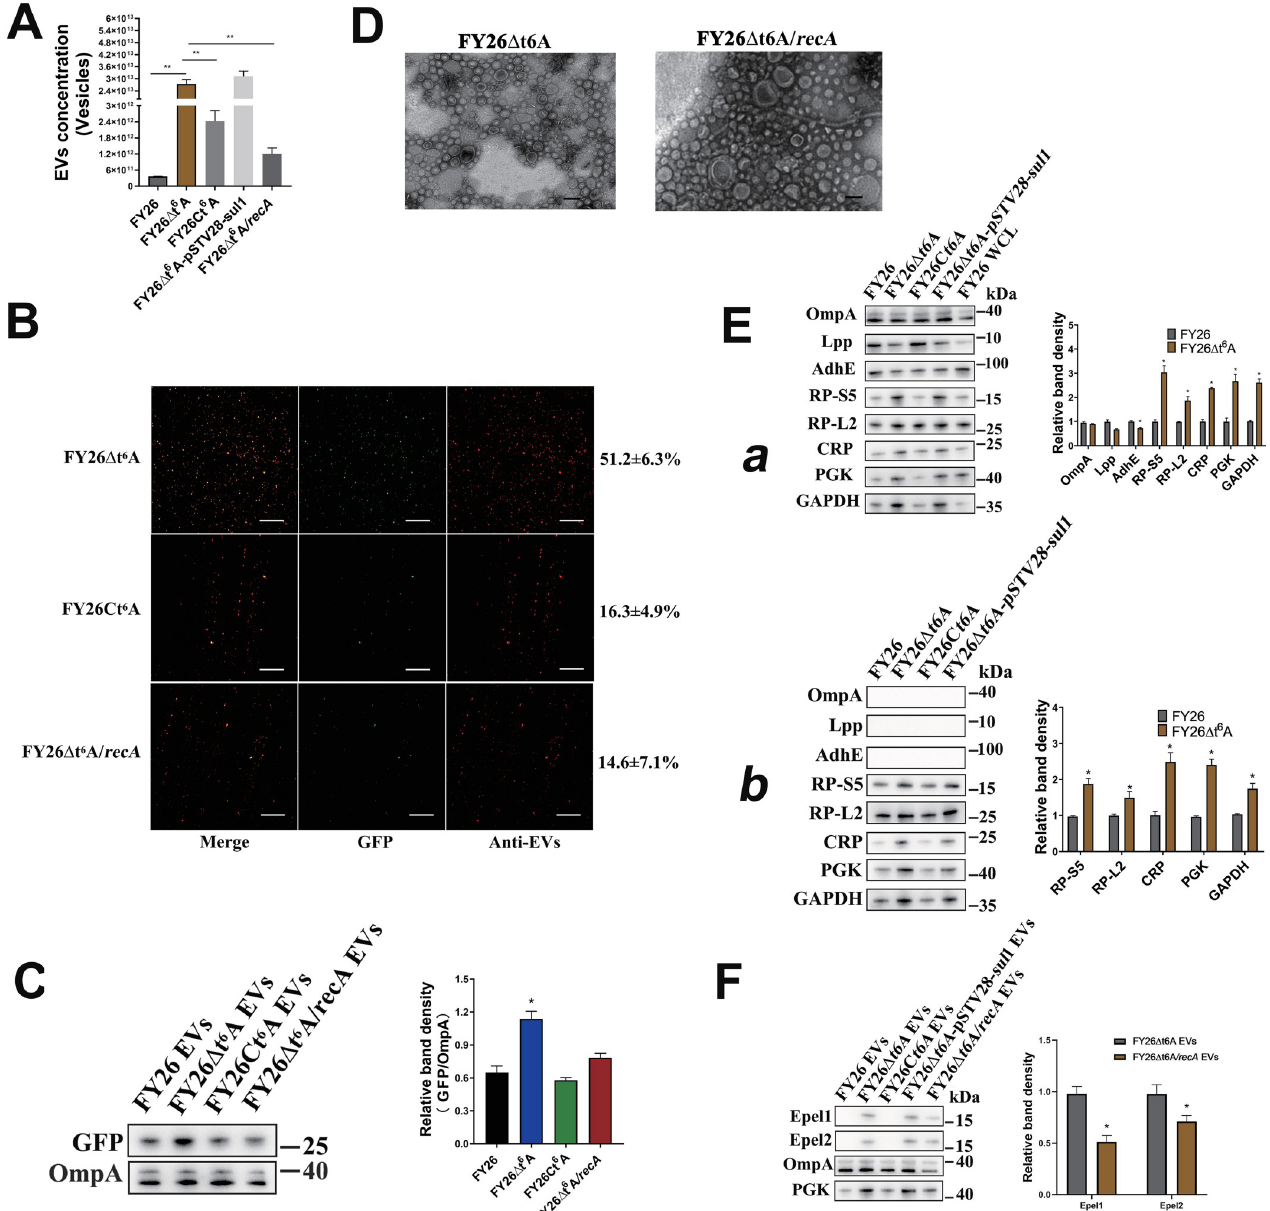
Fig 10. Absence of t 6 A synthesis genes in ExPEC enhanced the production of cytoplasm-carrying vesicles. (A) The concentrations of EVs purified from FY26 Δ t6A, FY26Ct6A and FY26 Δ t6A/ recA were determined with a nanoparticle tracking analysis (NTA). (B) Immunofluorescent staining of EVs produced by FY26 Δ t6A, FY26Ct6A and FY26 Δ t6A/ recA .Percentage of cytoplasm-carrying vesicles (green fluorescence) among the total EVs (red fluorescence) is indicated on the right. Graph shows a representative image. Scale bars: 10 μ m. (C) GFP and OmpA proteins in EVs were determined with western blotting. (D) The EVs produced by FY26 Δ t6A and FY26 Δ t6A/ recA were observed with transmission electron microscopy (TEM). Scale bars: 200 nm. (E) Levels of membrane and cytoplasmic proteins in EVs (a) and EV-free extracellular medium (b) from FY26 Δ t6A and FY26Ct6A were determined with western blotting. (F) Protein levels of endolysins Epel1 and Epel2 variants in EVs of FY26 Δ t6A and FY26 Δ t6A/ recA were determined with western blotting. significantly lower than those in FY26 Δ t6A (S11C Fig). Epel1 and Epel2 proteins were up-reg- ulated in FY26 Δ t6A WCLs compared with their expression in WT FY26 (S11D Fig). The pro- tein levels of endolysins in FY26 Δ t6A/ recA were approached the original levels in WT FY26